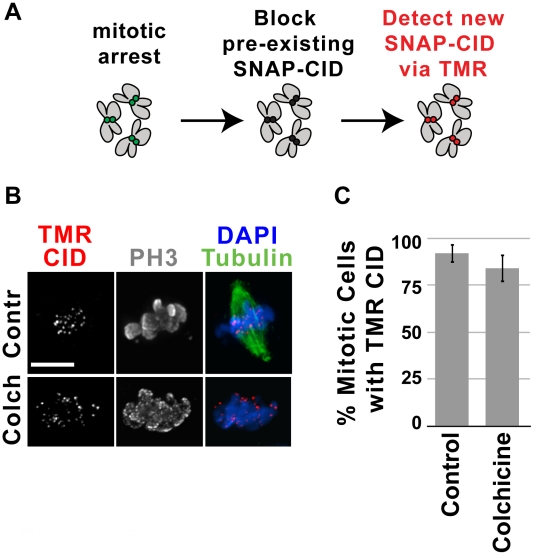
New CID recruitment occurs independently of microtubules.A) Experimental design for monitoring the recruitment of new CID during mitotic arrest induced by colchicine. Clonal S2 SNAP-CID cells were arrested in mitosis with either 12.5 µM colchicine or no drug (Contr) for two hours, then incubated with the BTP-block to quench all pre-existing SNAP-CID, and chased for four hours in the presence of colchicine. Newly-synthesized SNAP-CID was then detected by labeling with TMR. B) Representative images of SNAP-CID S2 treated (Colch) and not treated (Contr) with colchicine. TMR-labeled CID is shown in red, tubulin in green, phospho H3 in gray, DAPI in blue. Note that after treatment with colchicine cells lack spindle microtubules. New SNAP-CID recruitment occurs with efficiency comparable to untreated cells when cells are blocked in metaphase with colchicine (p = 1, Fisher's exact test). C) Control cells (no drug, n = 27) and cells treated with colchicine (n = 25) were scored for the presence or absence of centromeric TMR-labeled CID. Percent of cells (y-axis) with visible centromeric new SNAP-CID did not differ significantly (p = 0.4501, Fisher's exact test) in control cells compared to treated cells (x-axis). Error bars indicate standard error.